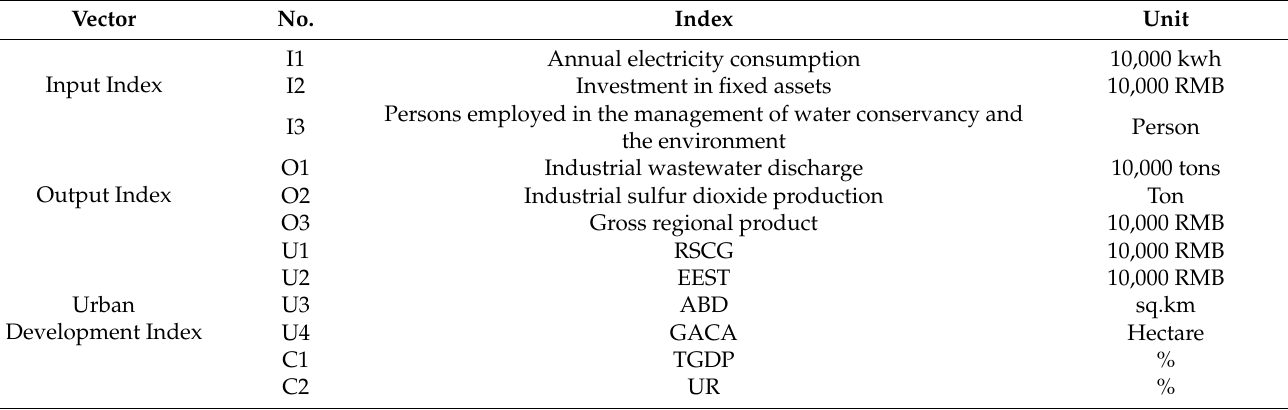
Table 1. Evaluation